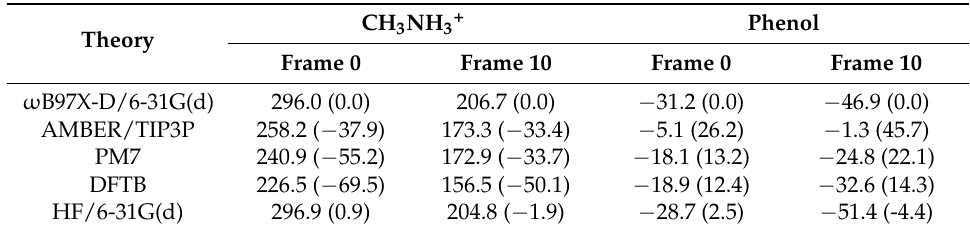
Table 1. ∆ E L (full, 10) values determined at various levels of theory for two snapshots. Values in parenthesis refer to relative